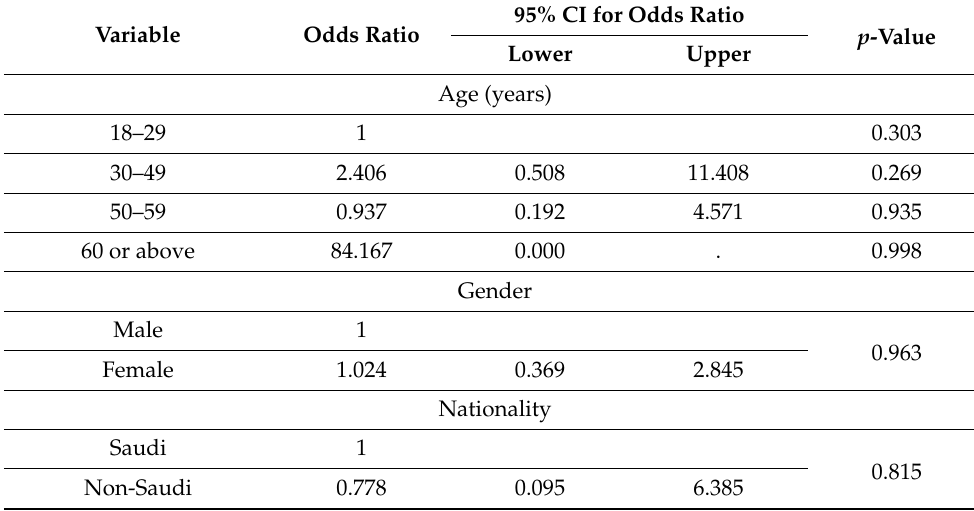
Table 4. Logistic regression with acceptance toward COVID-19 vaccine as the dependent variable (n =